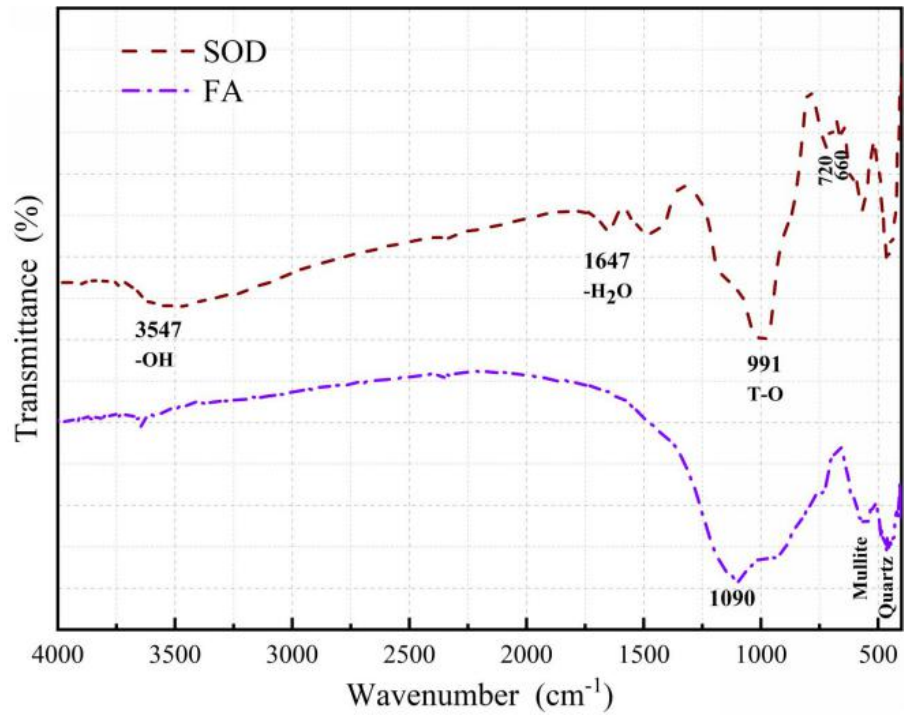
Figure 2. FTIR spectra of raw material (FA) and alkali-soluble desiliconization products (SOD). T-O stands for T-Si or T-Al.